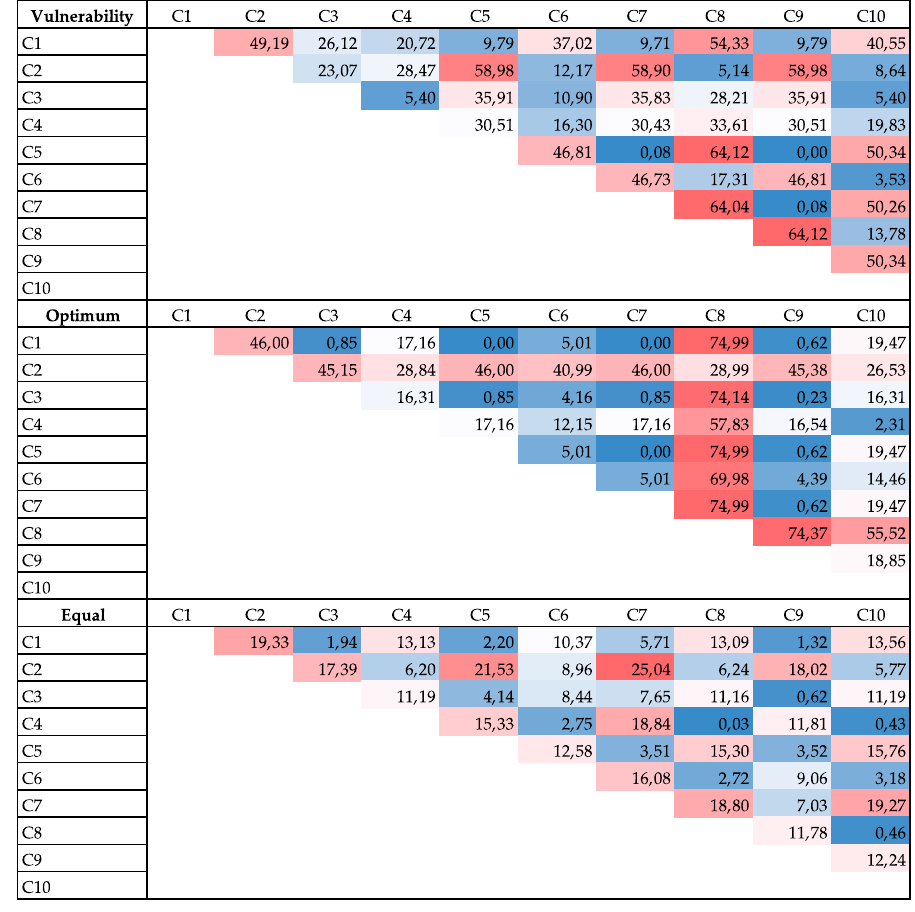
Figure 3. Pairwise comarca new Sustainable Rural Development Index—nSRDI divergence matrices by weighting approach (equal, optimal and vulnerability) based on distances between scores of the indicator. Dark red indicates high divergence and dark blue indicates low divergence. Values are in percentages.